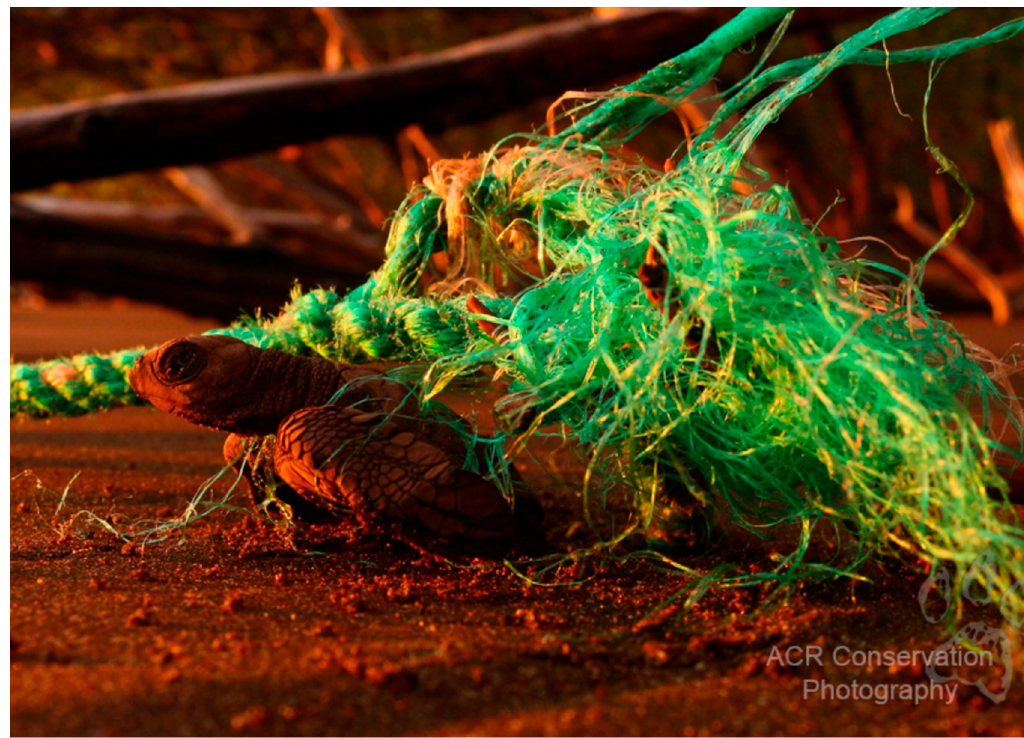
Figure 4. Adapted photo with permission (Photo by Alonso Sánchez from ACR Wildlife Photography, San José, Costa Rica 2022) of a documented olive ridley hatchling ( L. olivacea ) entangled in an old plastic robe washed upon the beach in Nancite, Costa Rica.